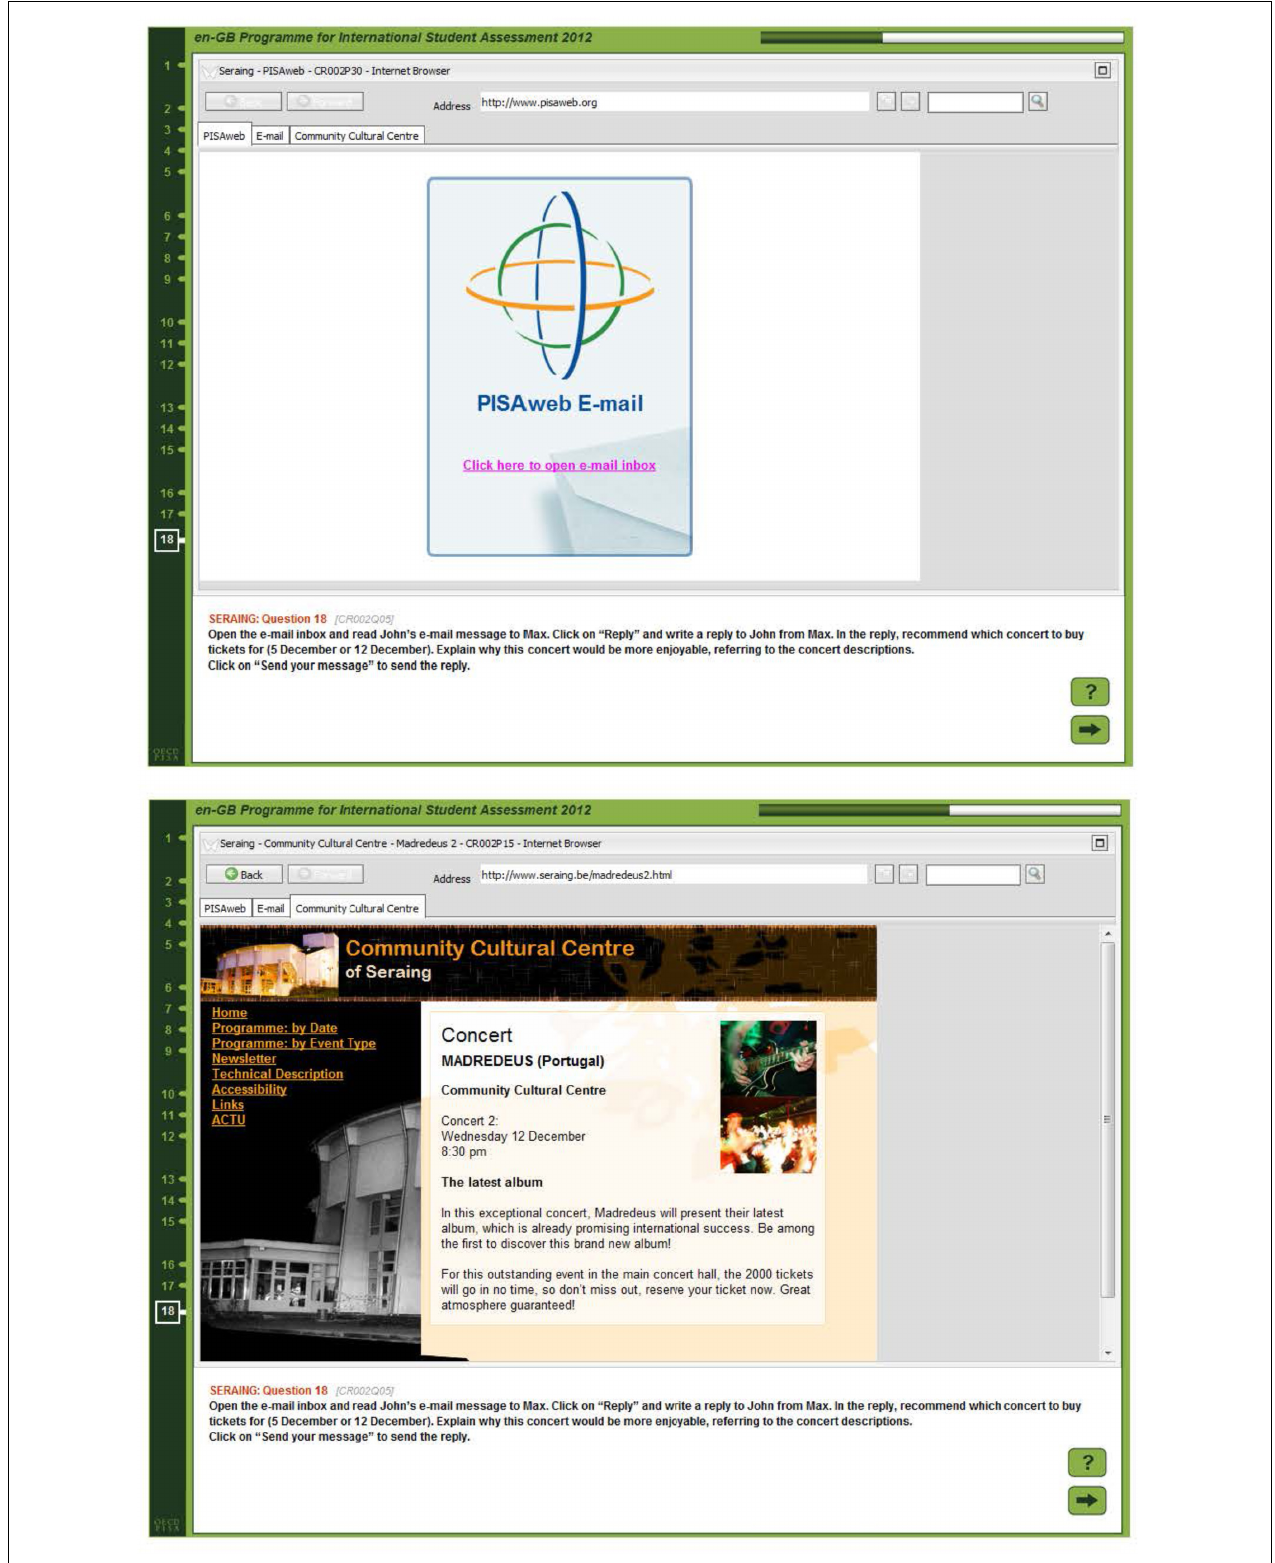
FIGURE 1 | Two screenshots from a digital reading task requiring complex navigation (see OECD, 2011, 2015).